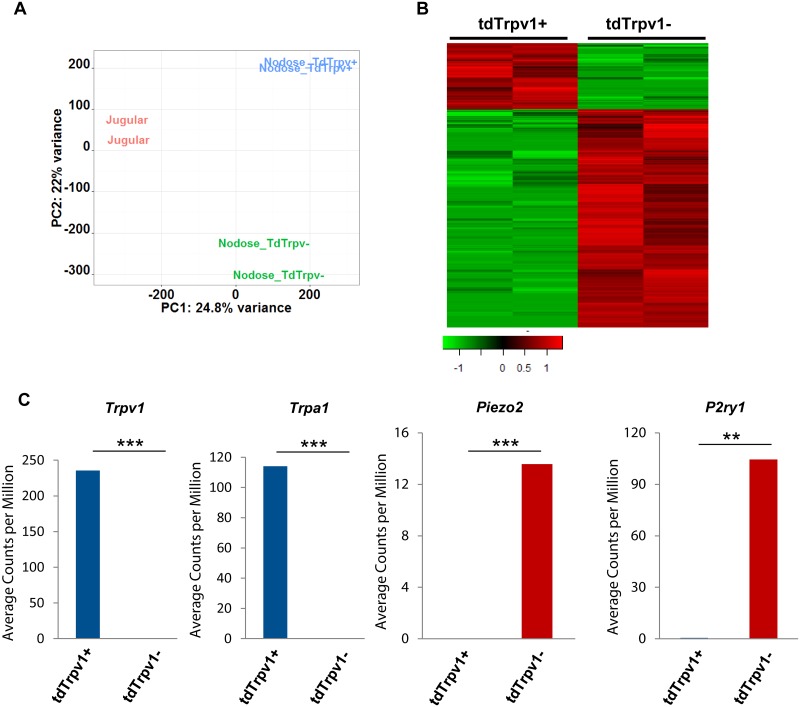
RNA sequencing revealed distinct gene expression between Trpv1-tdTomato positive and negative nodose C-fiber neurons.(A) Principle component analysis showing the overall expression patterns of jugular, Trpv1-tdTomato positive and negative nodose C-fiber neurons. Log2 transformed CPM from Trpv1-tdTomato selection dataset was used. (B) Heatmap showing expression of genes with significant expression difference between Trpv1-tdTomato positive and negative nodose C-fiber neurons. Log2 transformed CPM was used. Red indicates high expression, green indicates low expression. Color bar indicates z score. (C) Selected genes that are differentially expressed in Trpv1-tdTomato positive and negative nodose C-fiber neurons. Y-axis indicates average CPM from Trpv1-tdTomato selection dataset. Blue indicates Trpv1-tdTomato positive nodose neurons, red indicates Trpv1-tdTomato negative nodose neurons. P values were calculated based on group comparison. * p value ≤ 0.05; ** p value ≤ 0.01; *** p value ≤ 0.001. Data from TRPV1 selection dataset.